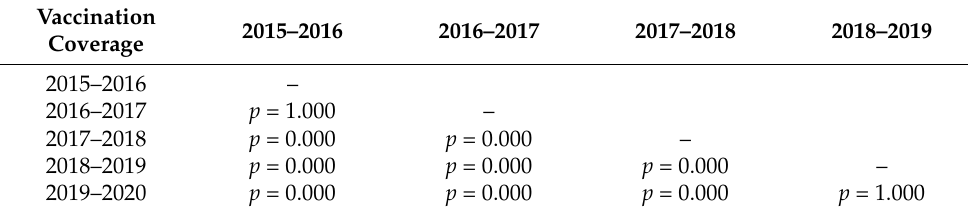
Table 4. Comparison of vaccination coverage, according to